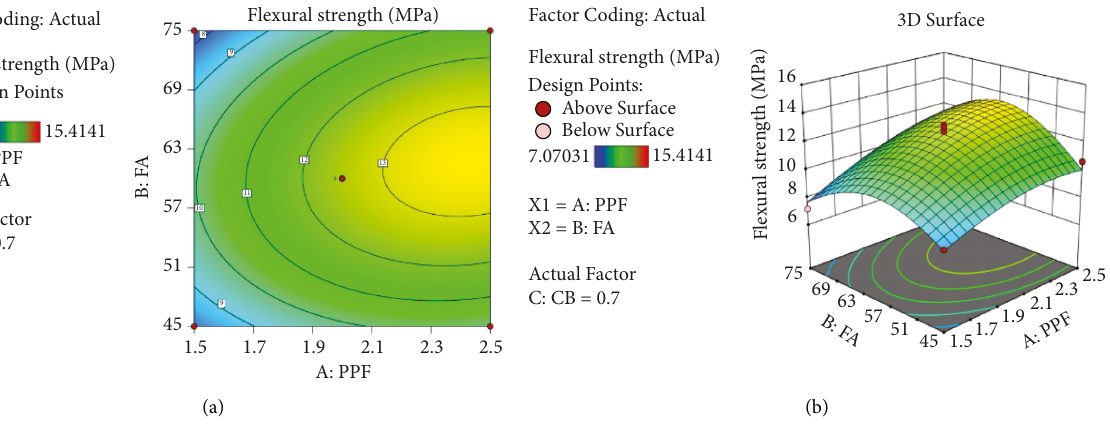
Figure 11: Contour plot of flexural strength. (a) R1. (b) 3D graph of